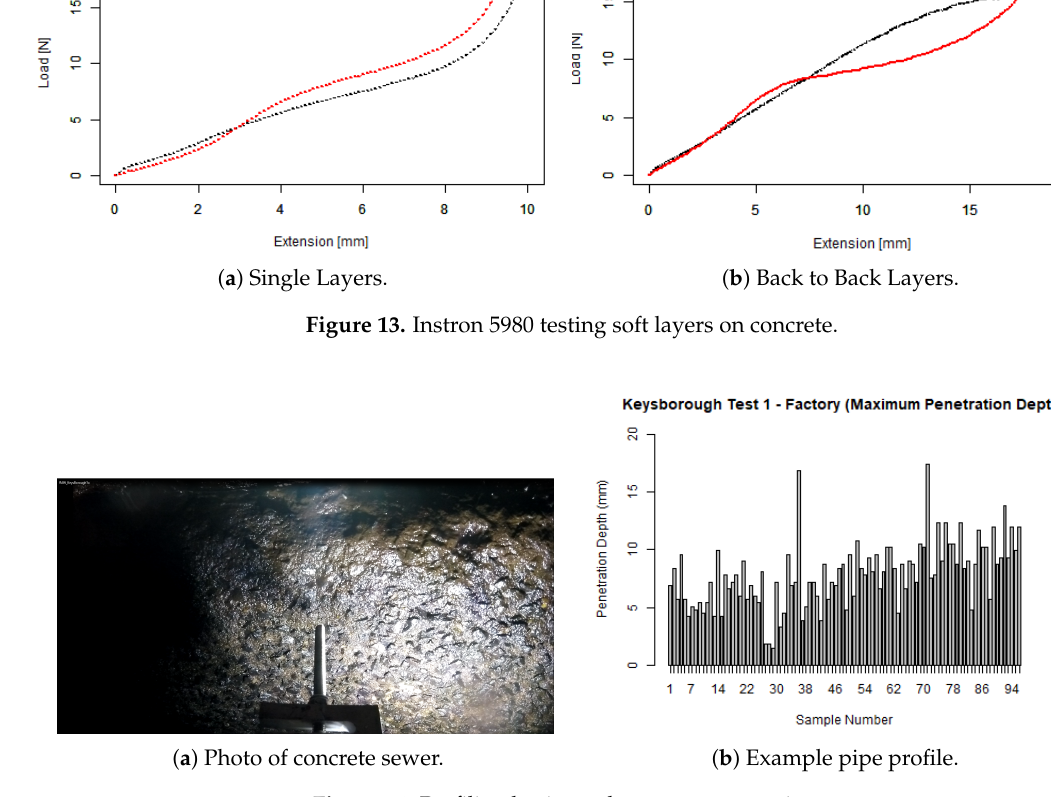
Figure 14. Profiling horizontal concrete sewer